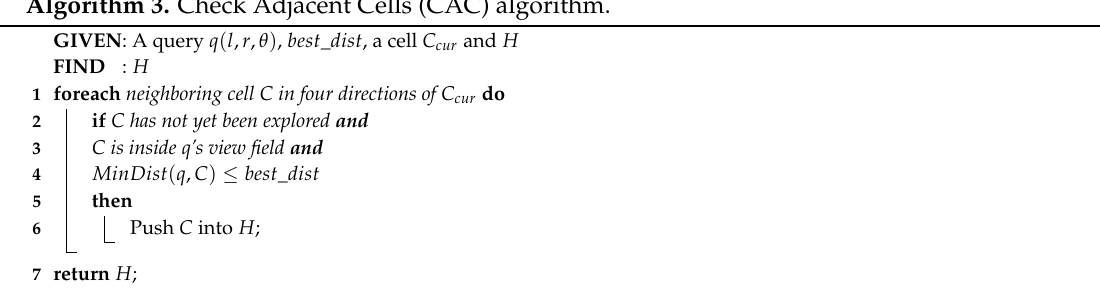
Algorithm 3. Check Adjacent Cells (CAC)